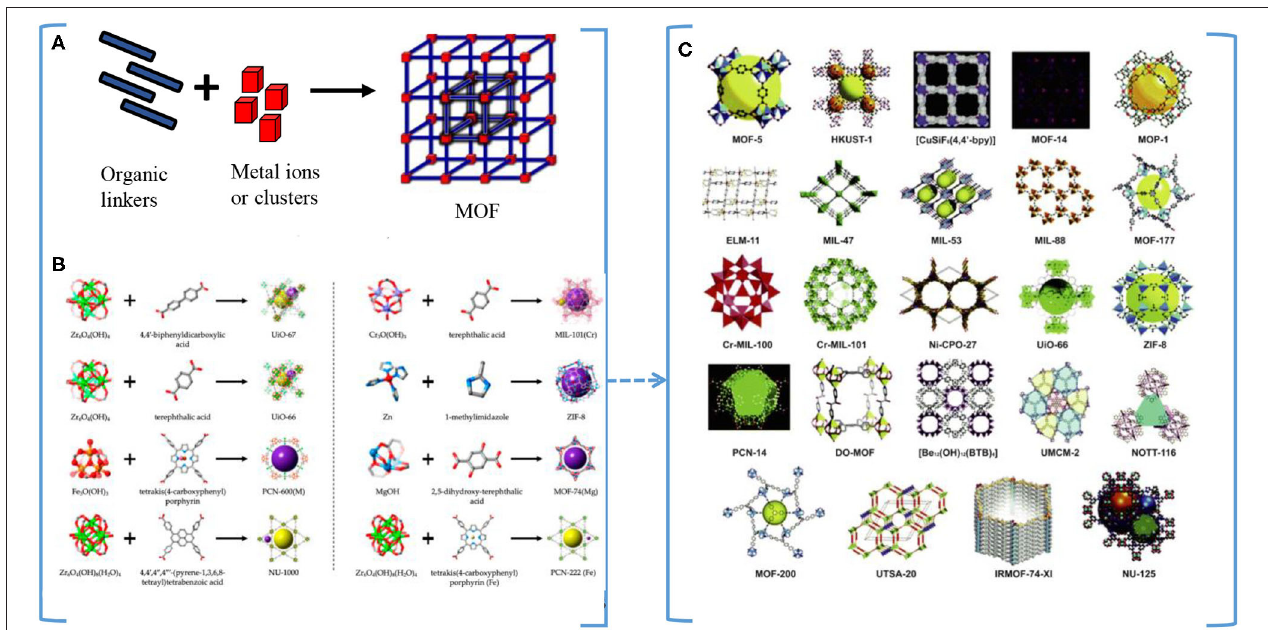
FIGURE 4 | (A) Metallic organic framework (MOF) basic structure. (B) Examples of different MOFs structures with their corresponding metallic clusters and organic linkers (Howarth et al., 2017), with permission from the American Chemical Society. (C) Examples of common MOFs structures (Qiu et al., 2014), with permission from the Royal Society of Chemistry.